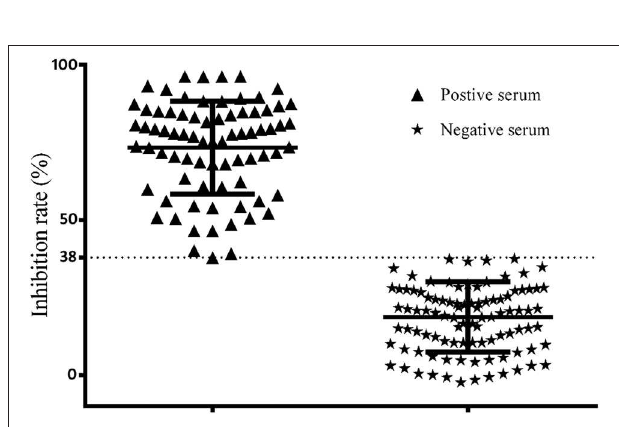
FIGURE 10 | The distribution of inhibiting rate by Dc-ELISA and setting up of the cut-off value.